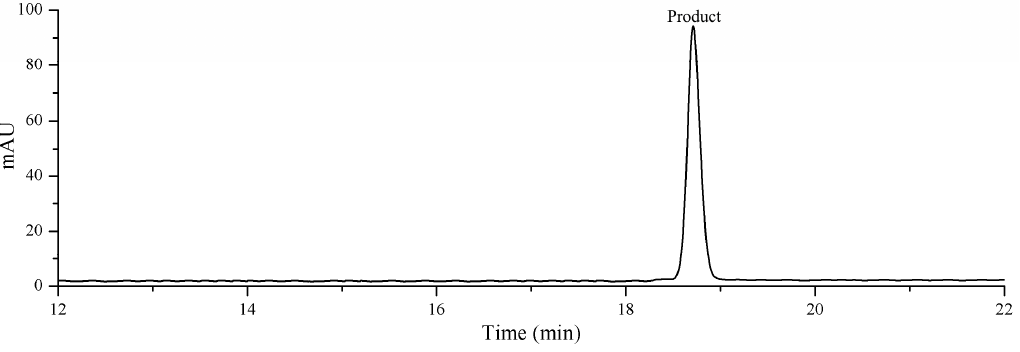
Figure 4. HPLC analysis of the purified gylongiposide I using Prep-HPLC.